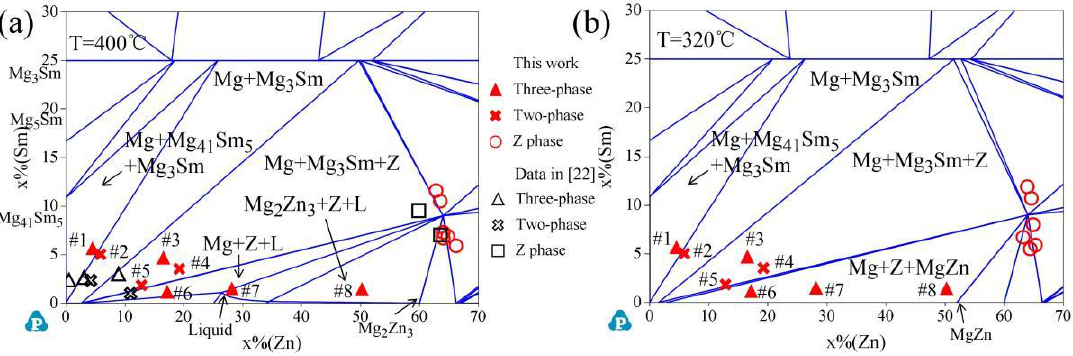
Figure 9. The calculated isothermal sections of the Mg-Zn-Sm system in the Mg-rich corner ( a ) at 400 °C and ( b ) at 320 °C.